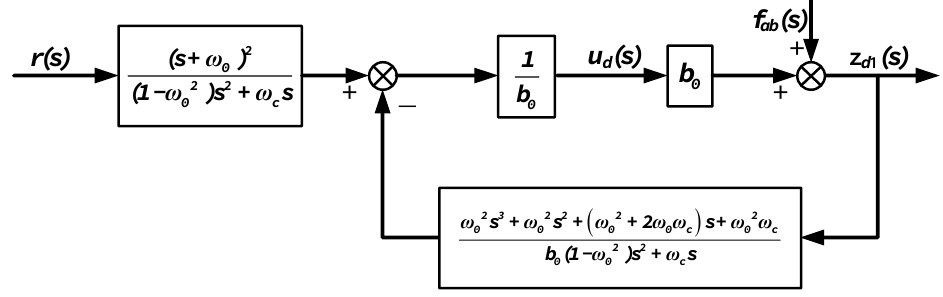
Figure 6. Optimal control law LADRC transfer-function-equivalent diagram.